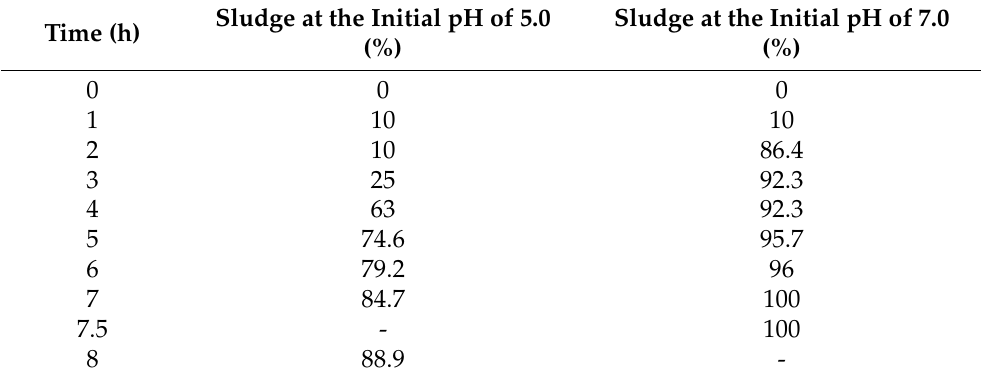
Table 4. The sludge formation at the initial pHs of 5.0 and 7.0.